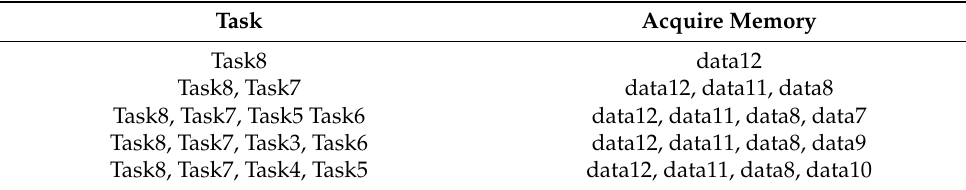
Table 2. Data-linked list.